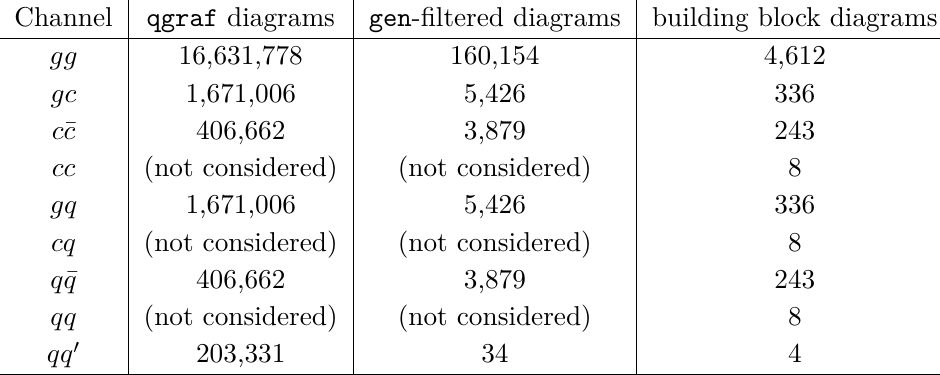
Table 1 . The number of “full” diagrams generated by qgraf and after filtering with gen , compared to the number of “building block” diagrams, for each channel. For the cc , cq and qq channels we have only applied the “building block”